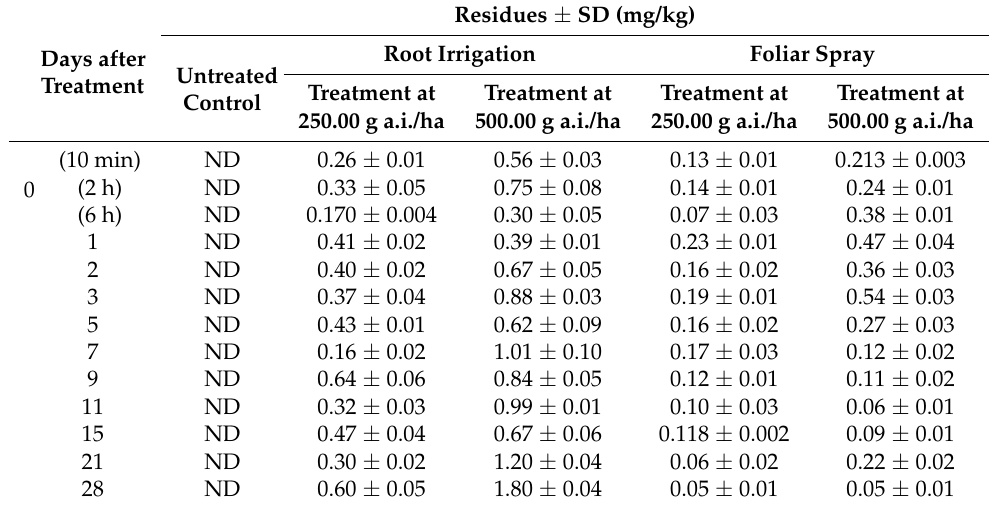
Figure 2. Fluopyram residue concentration in carrot roots expressed as the average of three biological replicates ± standard deviation. Table 2. Residues of fluopyram in the edible part (carrot